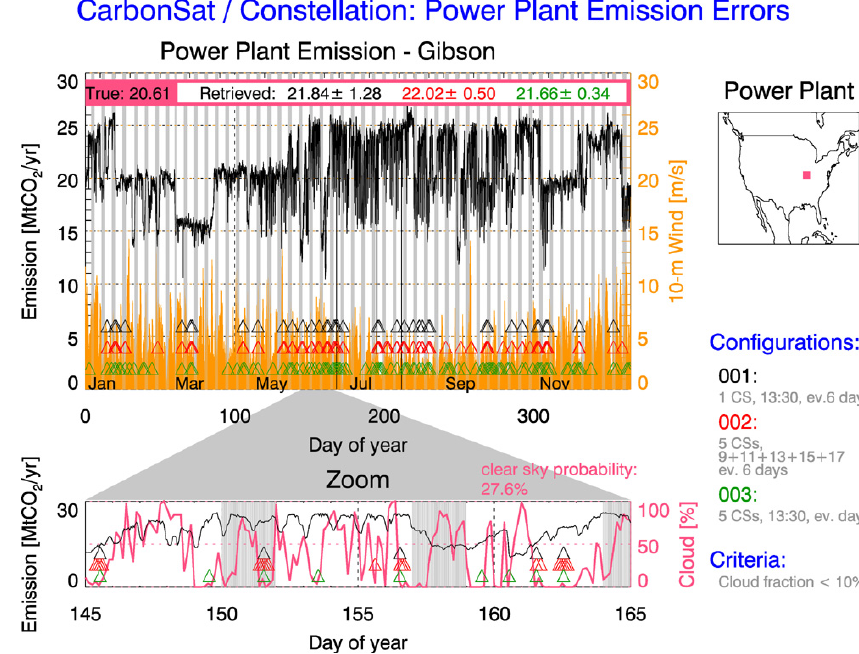
Fig. 7. Same as Fig. 6 for the power plant Gibson in